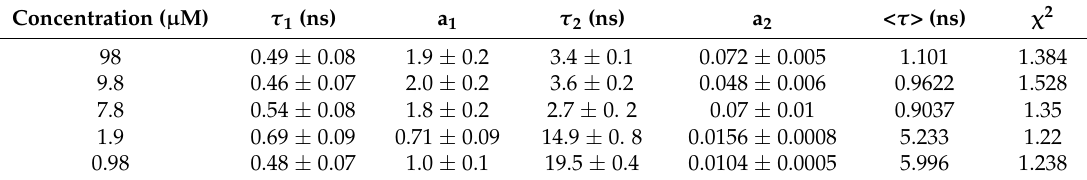
Table 1. Fluorescence lifetimes of LrtA (100 mM, phosphate buffer (pH 8.0), with 500 mM NaCl) at 25 ◦ C a